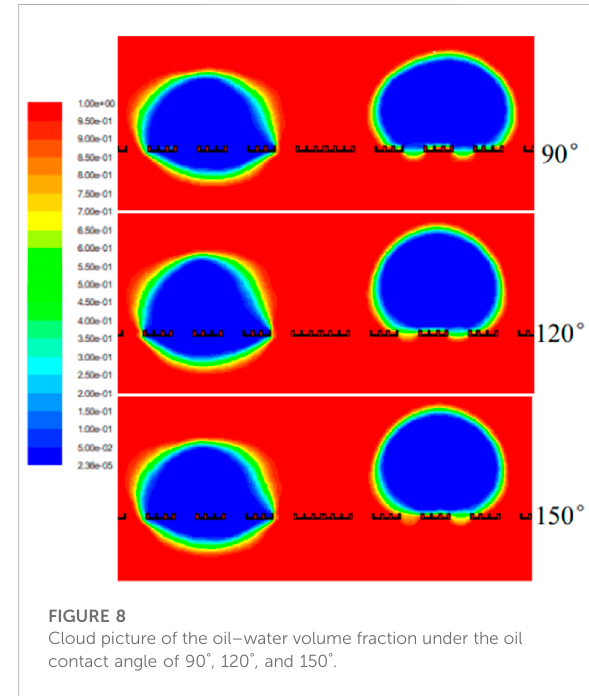
FIGURE 8 Cloud picture of the oil – water volume fraction under the oil contact angle of 90 ° , 120 ° , and 150 ° .